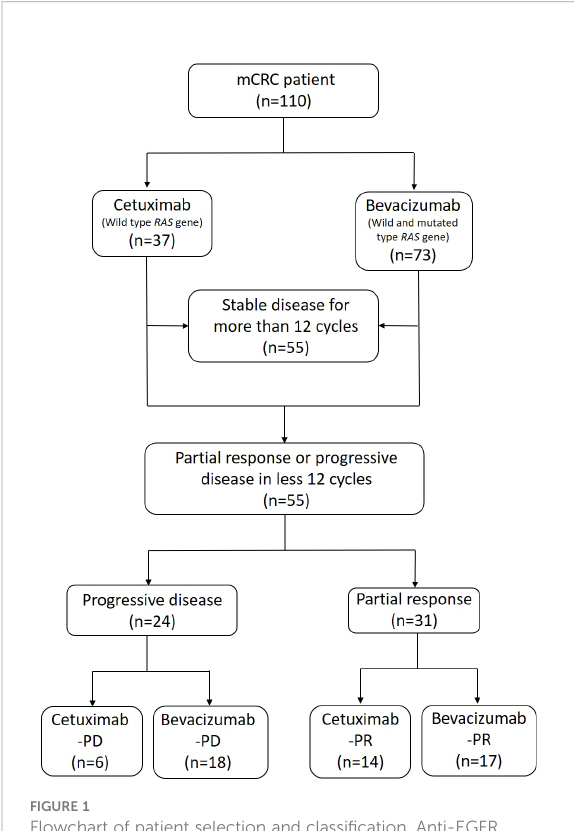
FIGURE 1 Flowchart of patient selection and classi fi cation. Anti-EGFR (cetuximab) and anti-VEGF (bevacizumab) agents were administered in accordance with the patients ’ general condition and with results on RAS gene expression. The patients received standard treatment for mCRC in combination with a FOLFIRI (folinic acid, 5-FU, and irinotecan) chemotherapy regimen. According to the patients ’ clinical response, we classi fi ed them into “ progressive disease ” and “ partial response ” groups. The patients were further classi fi ed into four subgroups with cetuximab-PD, bevacizumab-PD, cetuximab-PR, and bevacizumab-PR for the subsequent stool